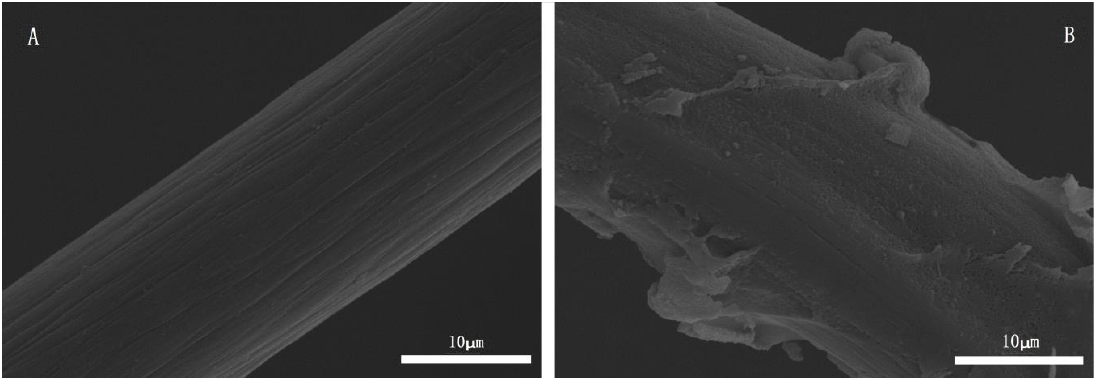
Figure 2. SEM micrographs of ( A ) untreated CF and ( B ) PMMA-g-CF.